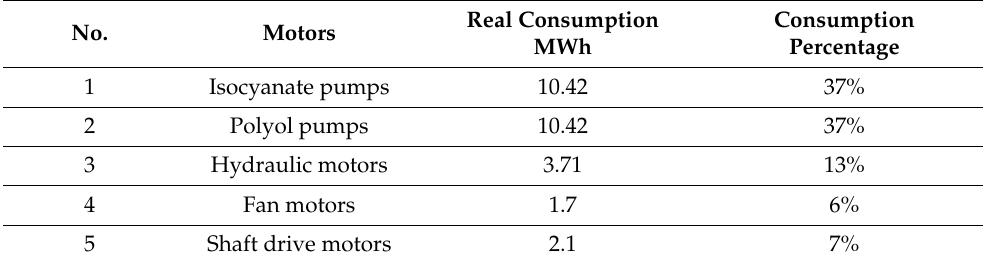
Table 6. Motors consumption for foaming installation component 1.